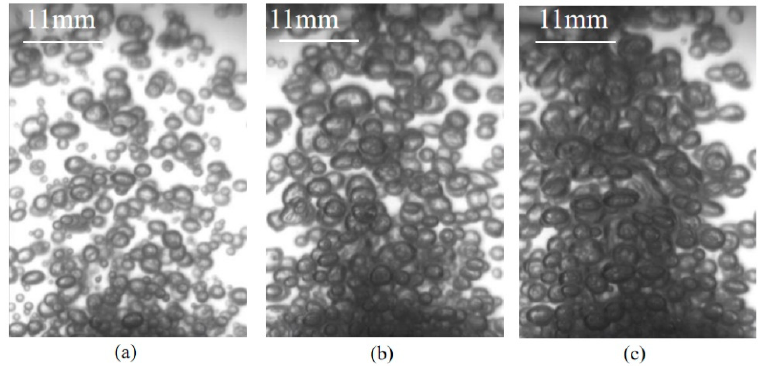
Figure 6. Distribution of bubbles from porous plug: ( a ) 30 NL/min, ( b ) 150 NL/min, ( c ) 300 NL/min.